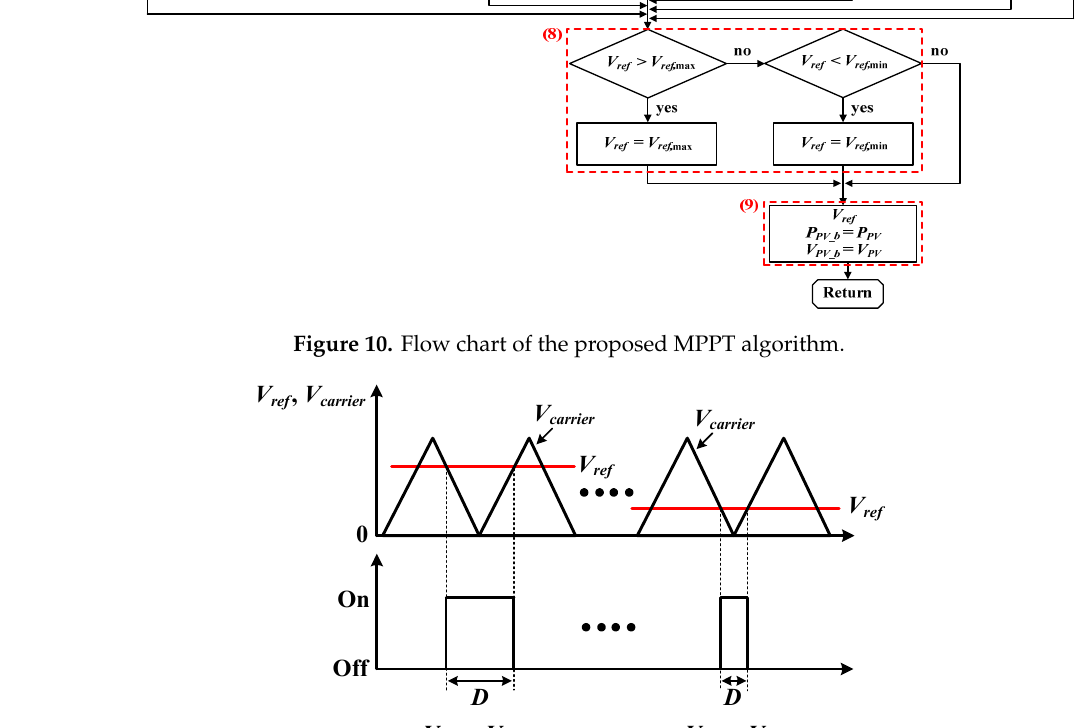
Figure 11. The process for generating a duty ratio ( D ) in the digital signal processor